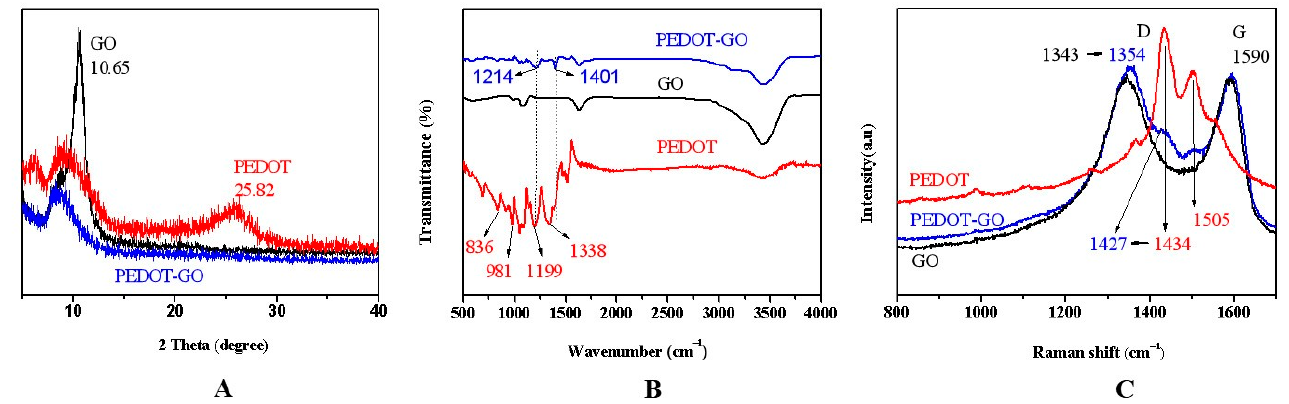
Figure 1. ( A ) XRD of GO, PEDOT and PEDOT-GO ( B ) FTIR spectra of GO, PEDOT and PEDOT-GO ( B ) Raman spectra of GO, PEDOT and